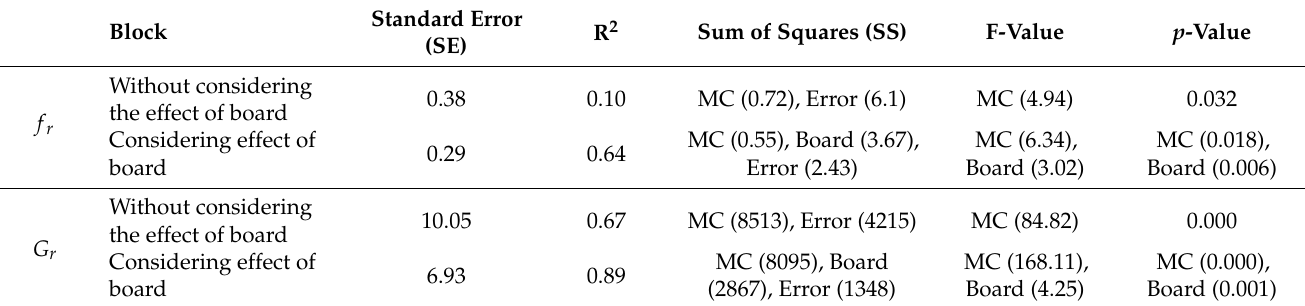
Table 3. Effect of moisture content on the RS properties.